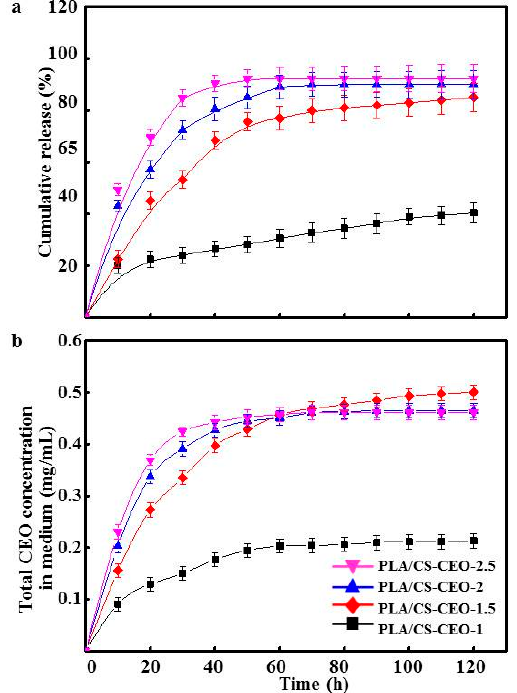
Figure 6. ( a ) Cumulative release of CEO from the PLA/CS-CEO fibers; and ( b ) total CEO concentration in medium from PLA/CS-CEO electrospun fibers.